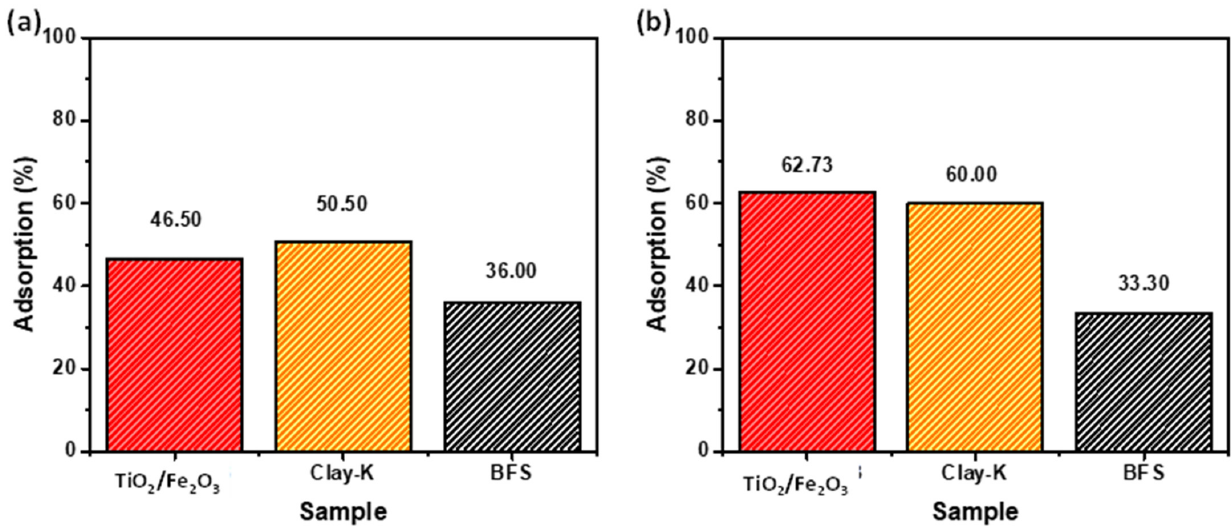
Figure 6. Percentage of cyanide adsorption in TiO 2 /Fe 2 O 3 , Clay-K, and BFS materials at initial concentrations of ( a ) 250 mg/L and ( b ) 750 mg/L NaCN. Adsorption time of 2 h.